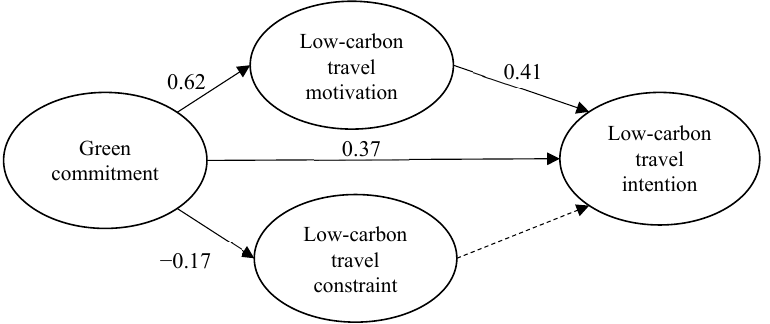
Figure 2. Final structural pattern diagram ( n = 358). Note: the solid lines represent significant effects ( p < 0.05), and the dashed lines represent no significant effects.